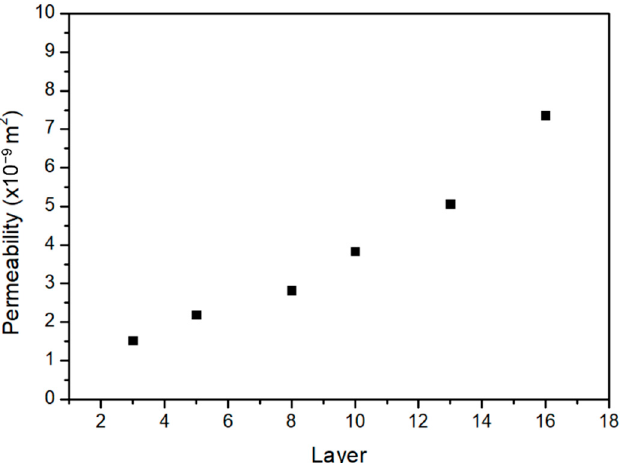
Figure 12. Relationship between permeability with number of layers obtain through simulation at inlet pressure 0.14 MPa.